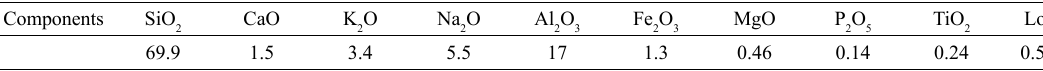
Table 2. Chemical composition of granite waste (wt.%).